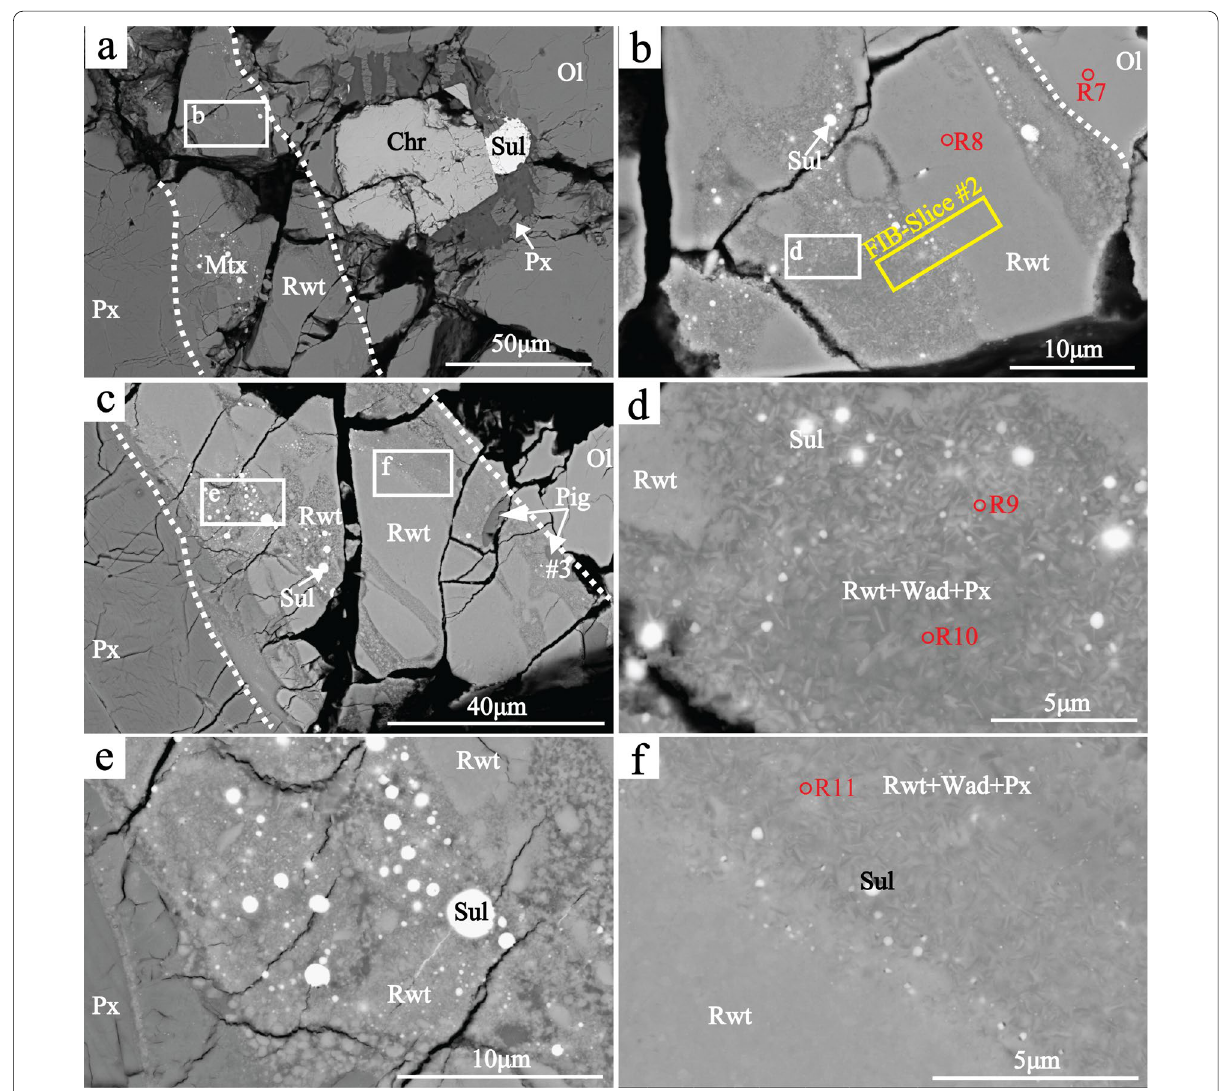
Fig. 4 BSE images of polycrystalline ringwoodite, rod-like ringwoodite and the coexisting wadsleyite in the shock-induced melt vein. a Low magnification BSE image shows a partially melted region (outlined with dotted line) with the presence of ringwoodite (Rwt) and matrix (Mtx). b Enlarged image of the white box “b” in a shows the polycrystalline ringwoodite with olivine (Ol) fragment pseudomorph. The yellow box is the position of FIB-slice #2. R7 and R8 are Raman analysis positions. c Higher magnification BSE image of the partially melted region in a , showing the presence of ringwoodite fragment and matrix. Pigeonite fragments (analyzed by Raman spectrum #3) are indicated by the white arrow. d Enlarged image of white box “d” in b . Raman spectra (R9 and R10) the intergrowth of ringwoodite, wadsleyite (Wad) and pyroxene (Px). The white spheres are sulfide (Sul). e Enlarged image of the white box “e” in c shows the texture of the shock-induced melt. The presence of ringwoodite was confirmed by Raman analysis, and the white spheres are sulfide. f Enlarged image of the white box “f” in c shows the intergrowth of rod-like ringwoodite, wadsleyite, and pyroxene in the matrix and the polycrystalline ringwoodite fragment. The small white grains are sulfide. Other abbreviations are the same as